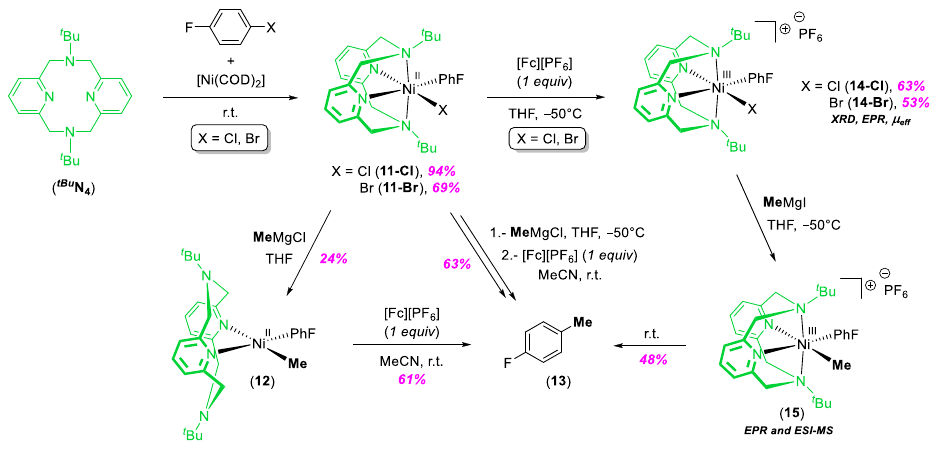
Scheme 4. Proof of concept for the participation of aryl-Ni III complexes 14-Cl , 14-Br, and 15 in C – C bond forming reactions with alkyl Grignard reagents. Adapted from reference